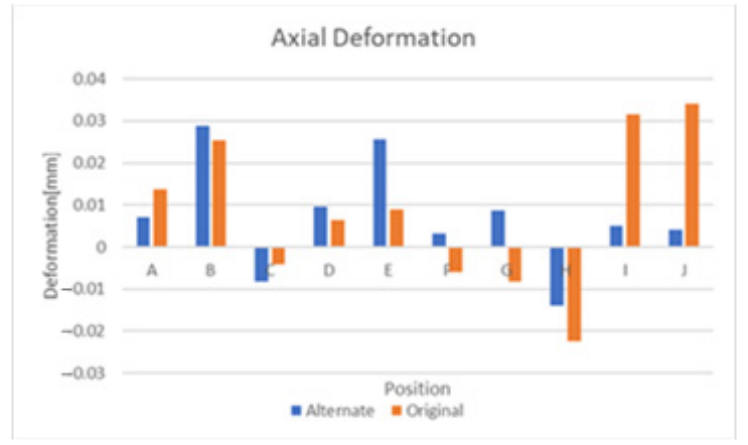
Figure 20. Axial deformation with symmetric substrate.